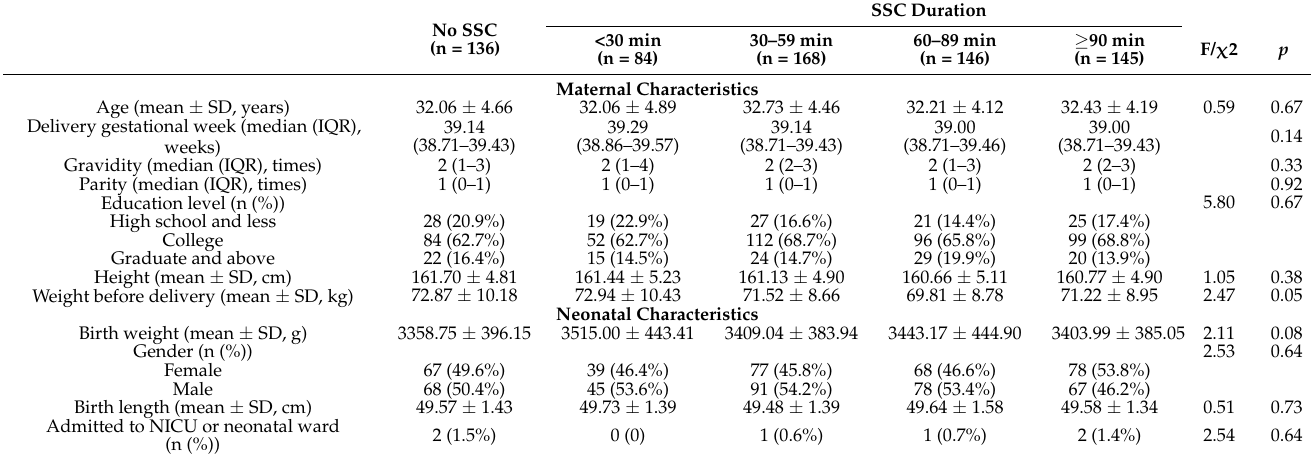
Table 1. Maternal and neonatal characteristics of participants according to SSC duration after CS.